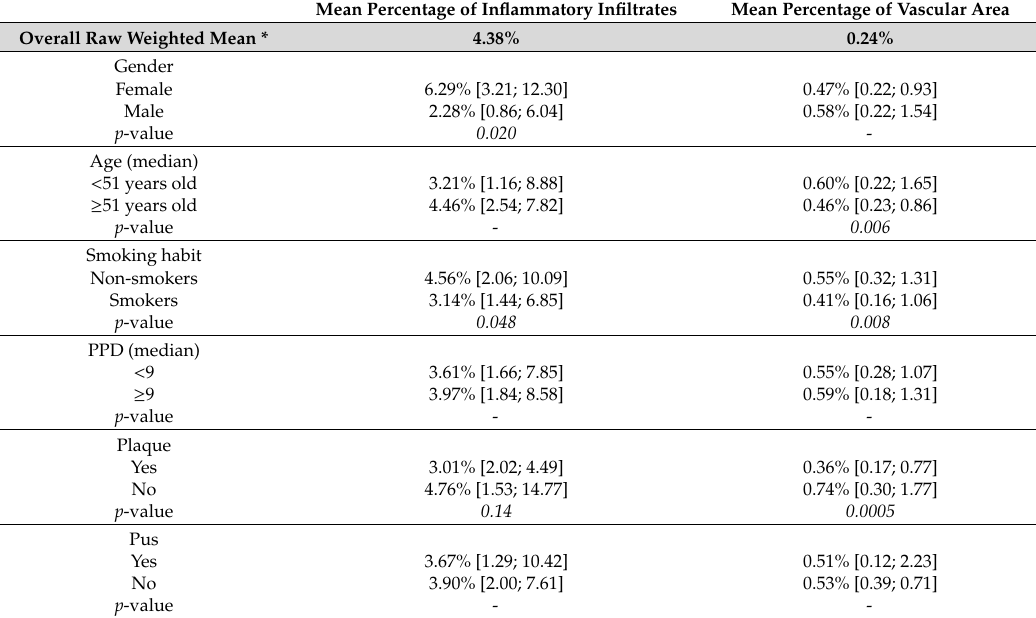
Table 2. Mean percentage [and 95% CI] of inflammatory infiltrated and vascular area. * Raw log-means were estimated weighting for the inverse of variance within a patient and then transformed through exponential function. Only p-values of variables selected through backward regression models are